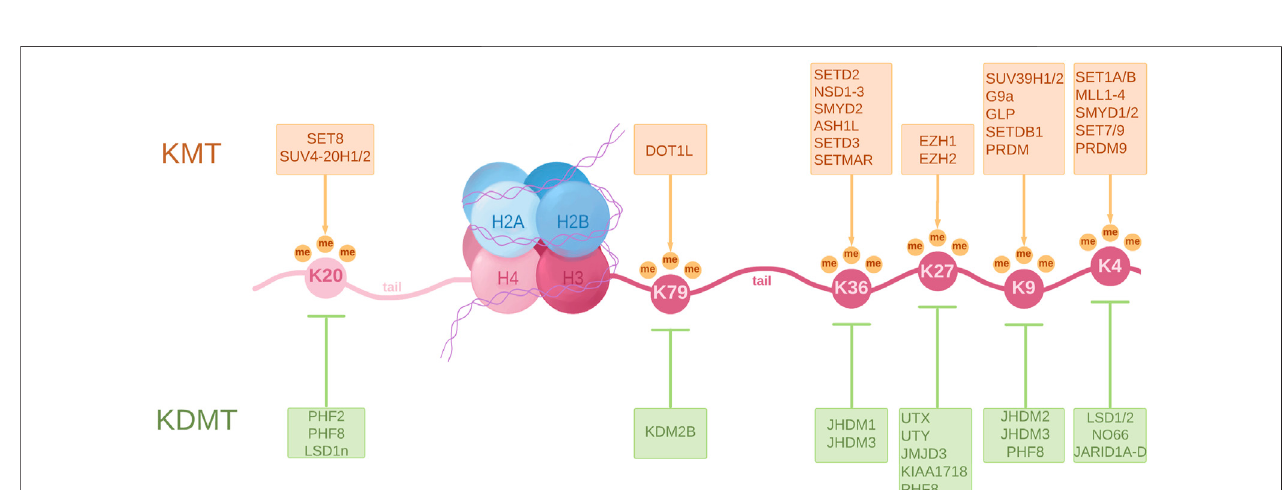
FIGURE 1 | A schematic representation of a nucleosome showing principal lysine methylation sites on histones H3 and H4 and the associated lysine methyltransferases (KMT) and lysine demethylases (KDMT). KMTs transfer one to three methyl groups to speci fi c lysine residues. These are associated with different functions such as transcriptional activation, commonly involving H3K4me2/3, H3K36me3 and H3K79me3, transcriptional repression in the case of H3K9me2/3, H3K27me2/3 and H4K20me3, and even DNA repair in the case of H4K20me2. KDMTs remove these methyl groups and help establish a tight regulation of gene activity. The full scope of histone methylation is, however, extremely complex as itinvolves a certain “ histone code ” that regulates the spatiotemporal differences in gene expression.